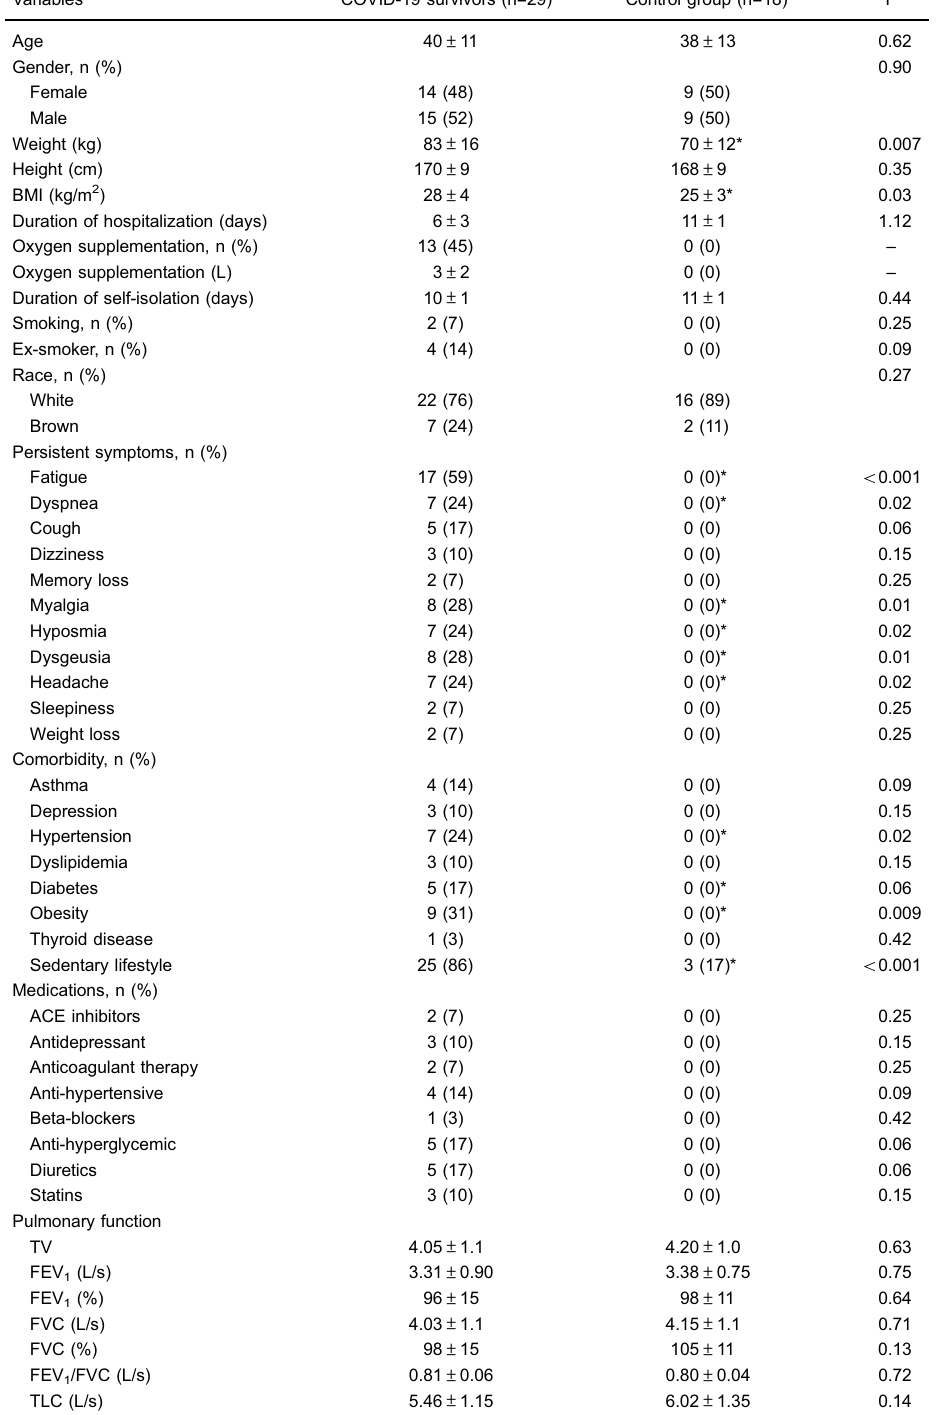
Table 1. Clinical characteristics and pulmonary function of COVID-19 survivors and control